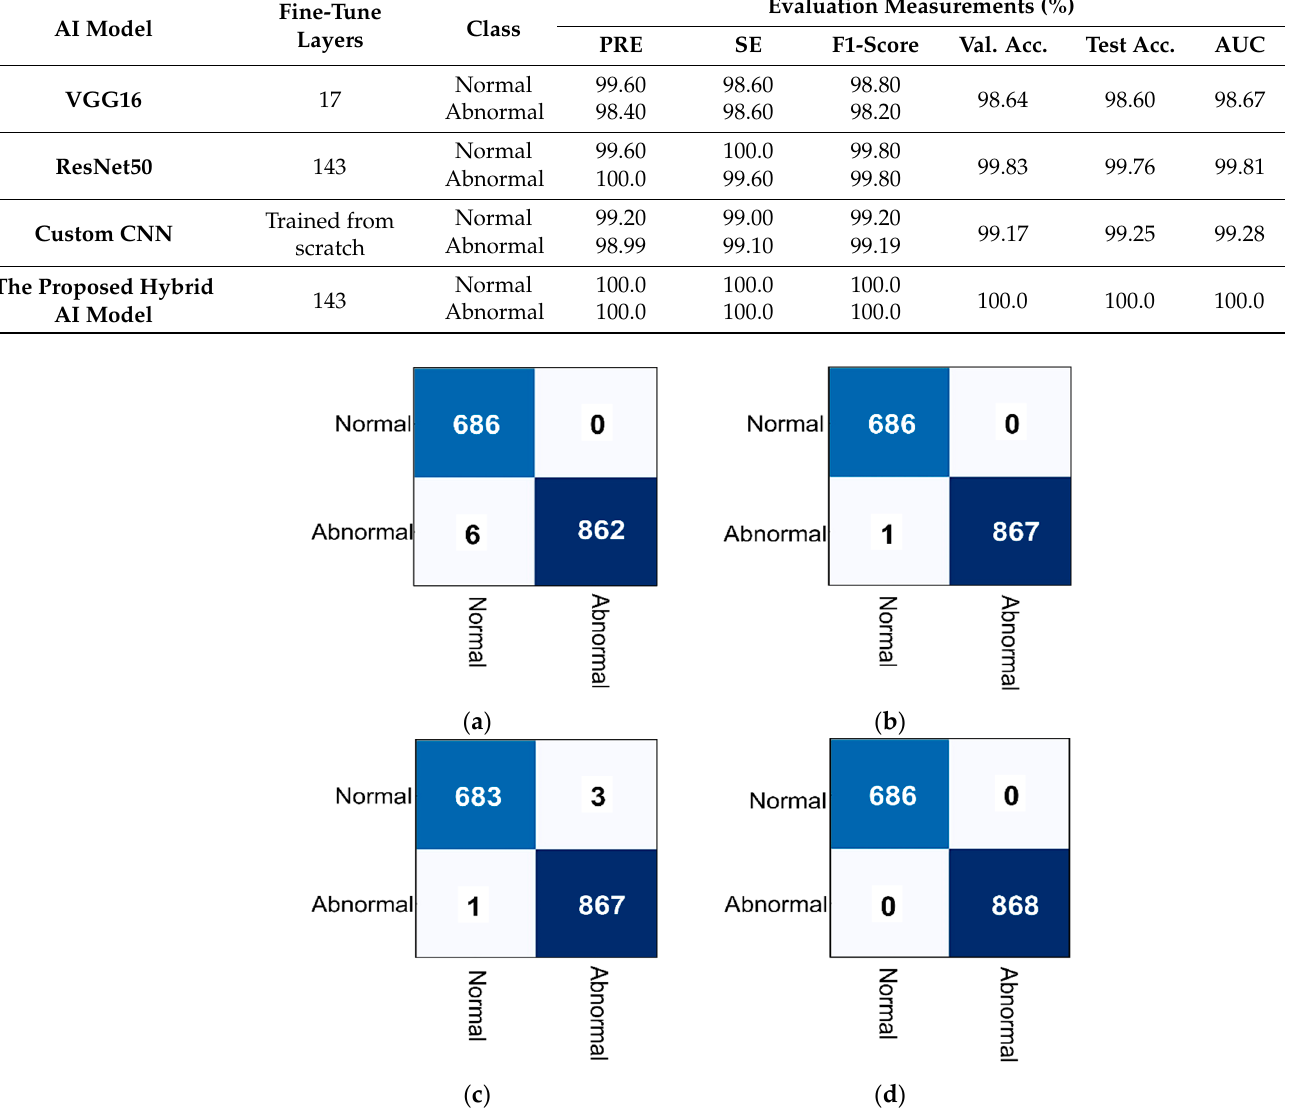
Figure 6. The confusion matrices of scenario A (i.e., binary classification) for the AI models: ( a ) The VGG-16, ( b ) The ResNet50, ( c ) The proposed custom CNN model, and ( d ) the proposed hybrid AI model. Table 7. Scenario A evaluation performance via four AI models using Dataset 1 without cross-vali- dation.